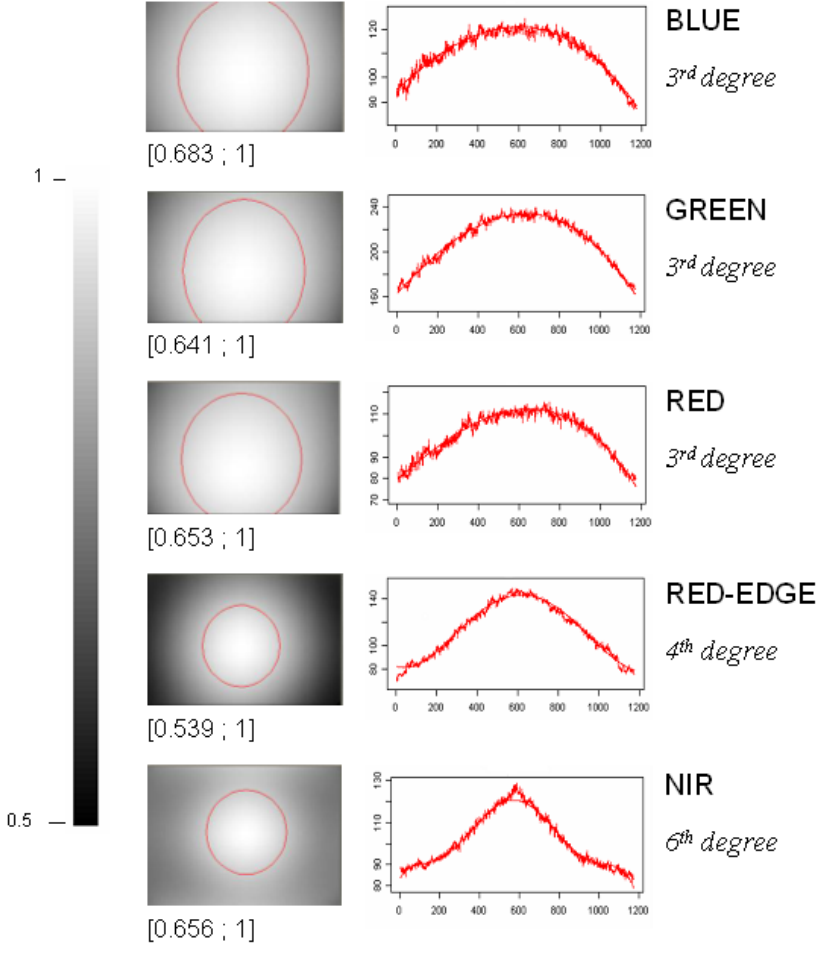
Figure 9. Vignetting filters for the Visible, RDG and NIR images (the circles are iso- contours for a signal loss of 10%), and the corresponding fitted diagonal